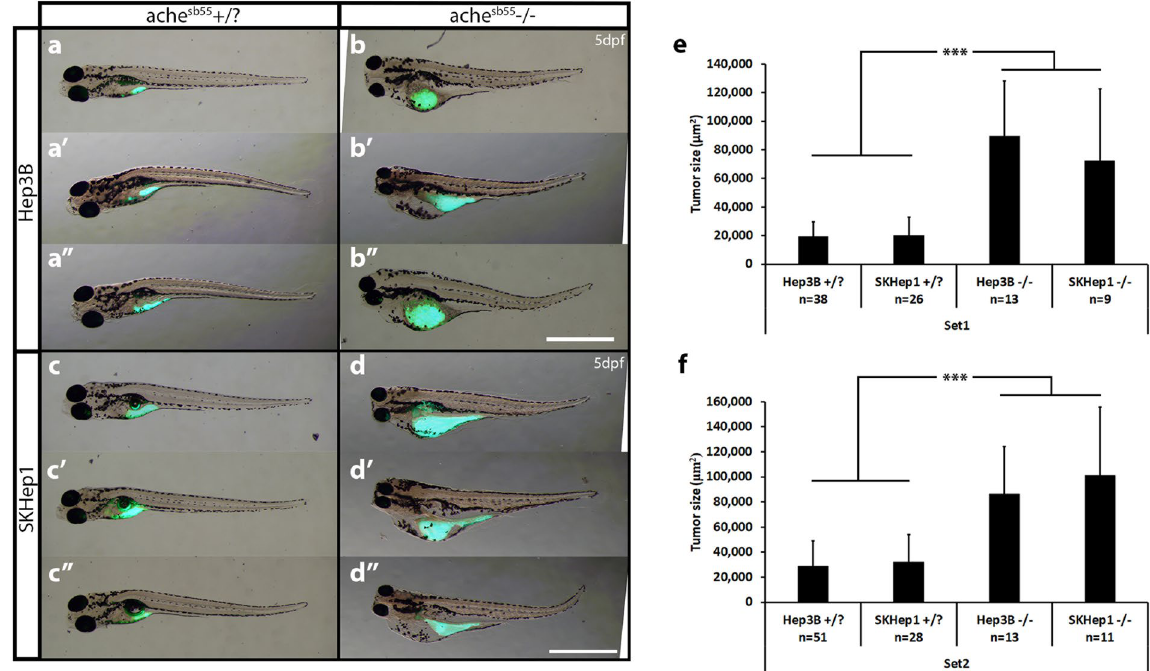
Figure 4. ache mutant embryos develop larger tumors with both Hep3B and SKHep1 human liver cancer cell xenotransplantation. At 2 dpf, embryos collected from ache + / − in-cross were injected with either Hep3B ( a , b ) or SKHep1 ( c , d ) cells. At 3 dpf, tail test was applied for phenotypically separating wild-type ( a , c ) and mutant embryos ( b , d ). At 3 dpi, larvae were fixed and imaged for analyzing tumor development (representative of Hep3B and SKHep1 injected groups, three different larvae are shown in a, a’, a”, b , b’, b” and c , c’, c”, d , d’, d”, respectively). Merged images from brightfield and GFP channels were shown. DiO labeled tumor masses can be clearly seen in green. Tumor sizes were measured in ImageJ using the fluorescent signal alone. In total 89 Hep3B injected ache + /?, 26 Hep3B injected ache − / − , 54 SKHep1 injected + /? and 20 SKHep1 injected − / − larvae were analyzed across two independent experiments. Results from each experimental set are separately graphed ( e , f ). Error bars represent the standard deviation. Bar = 1